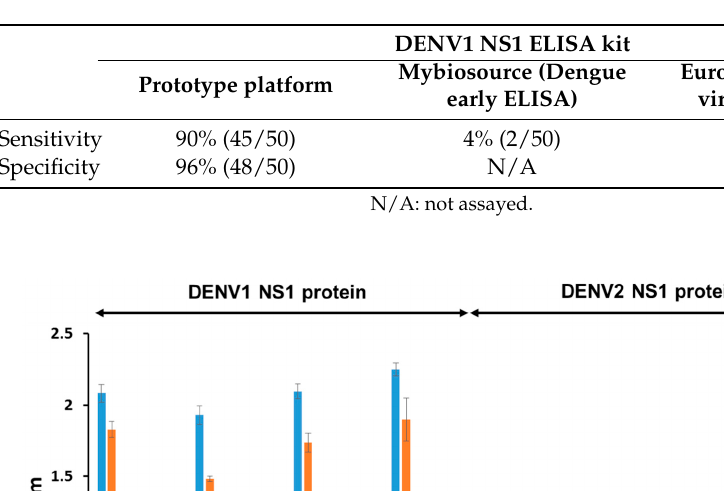
Table 2. Sensitivity and specificity of three different NS1 ELISA platforms.